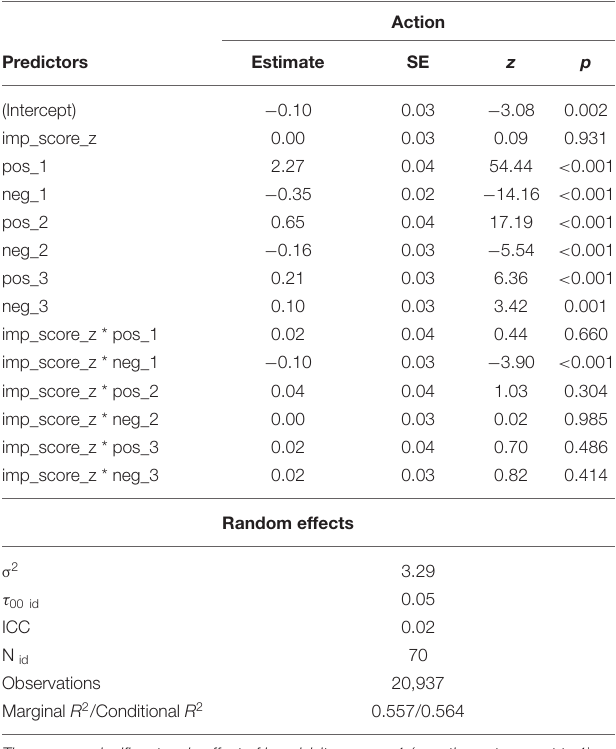
TABLE 1 | Statistical output from the GLME model with impulsivity interactions fit over both blocks jointly across participants ( n = 70).